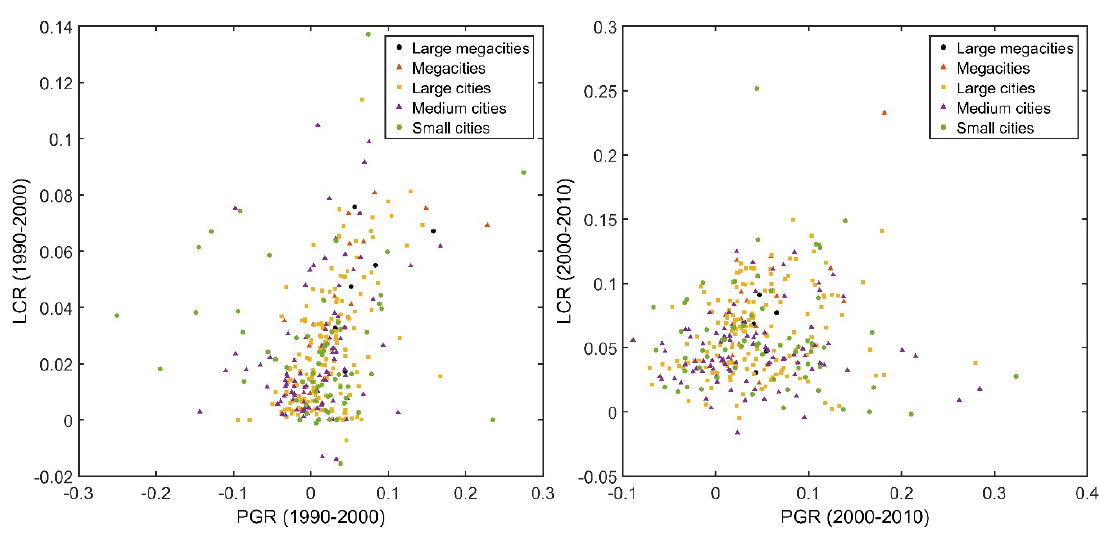
Figure 9. The scatter plots of LCR and PGR in